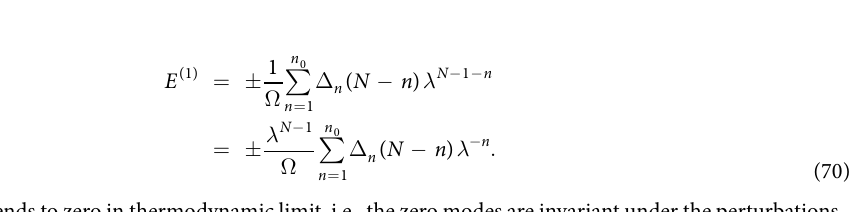
and  closes to  2 as N zm